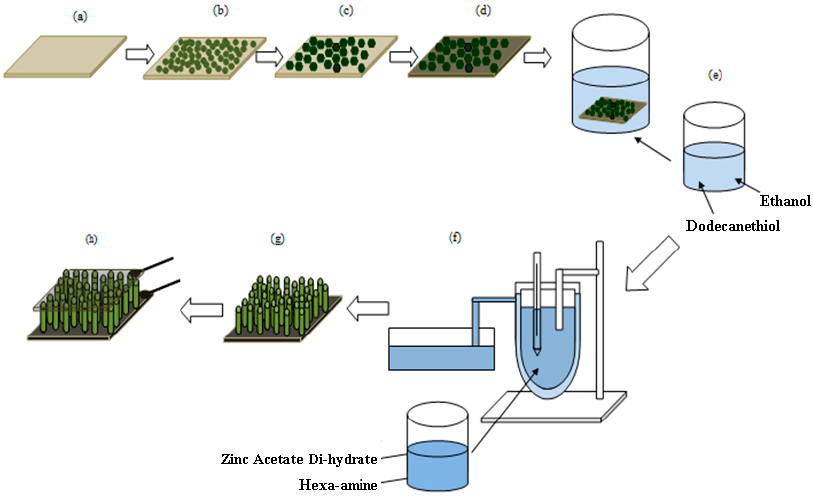
Figure 10. ( a ) The aluminum substrate; ( b ) the porous membrane formed after 1st step of